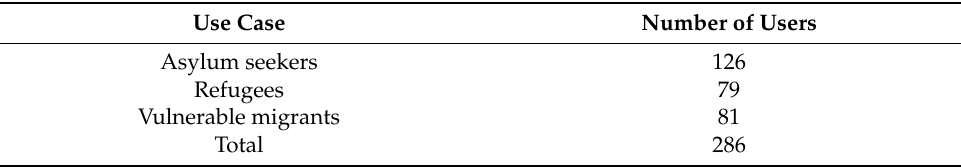
Table 1. Share of participants per type of